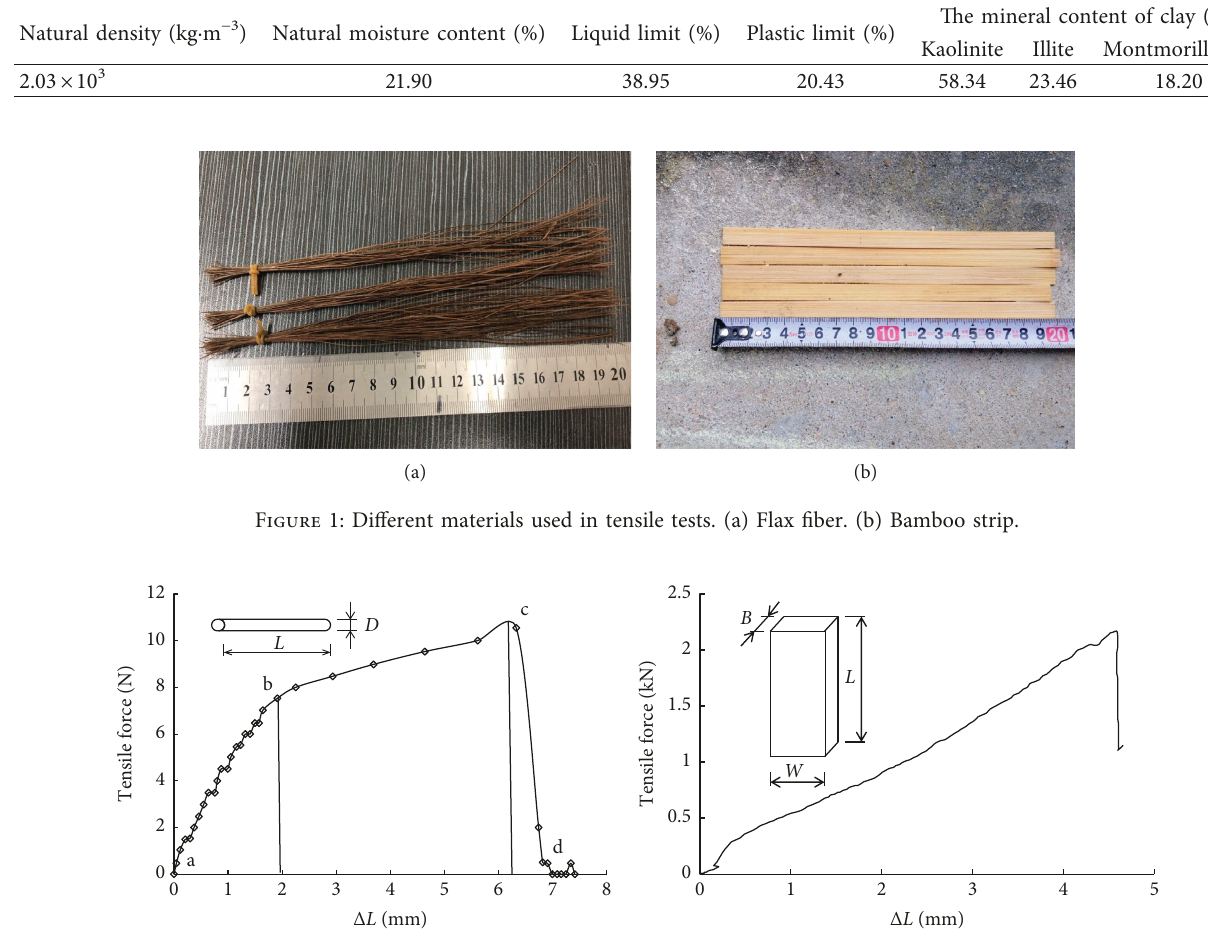
Table 1: Some physical properties of clay.